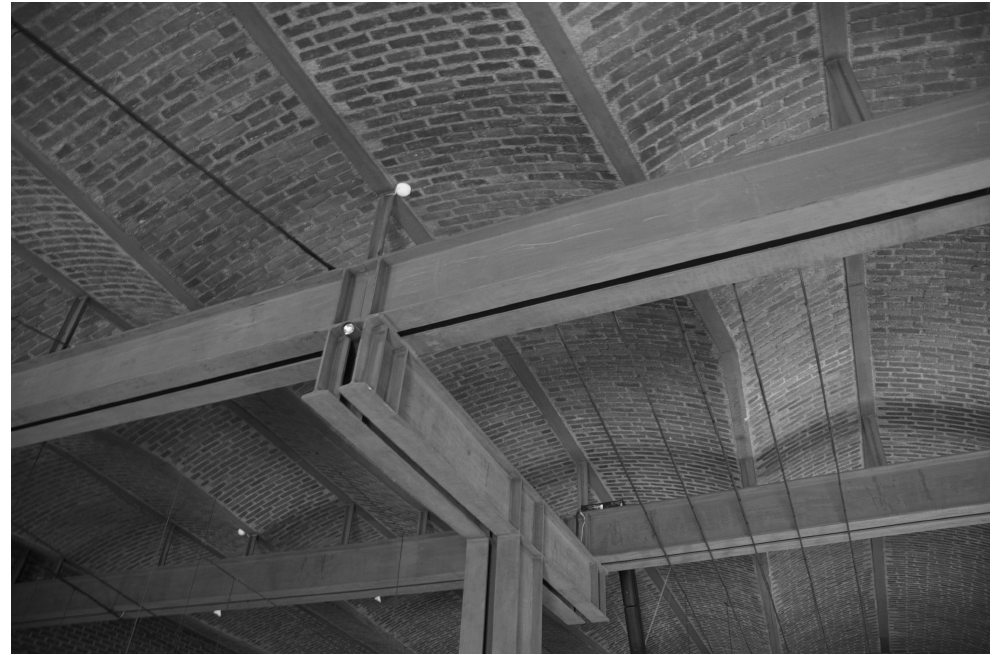
Figure 5: The vaulted roof